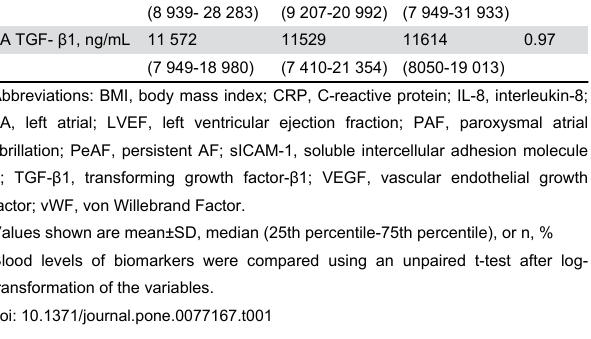
Table 2. EAT Volumes and Regional EAT Thickness in the Study Population According to the Type of Atrial